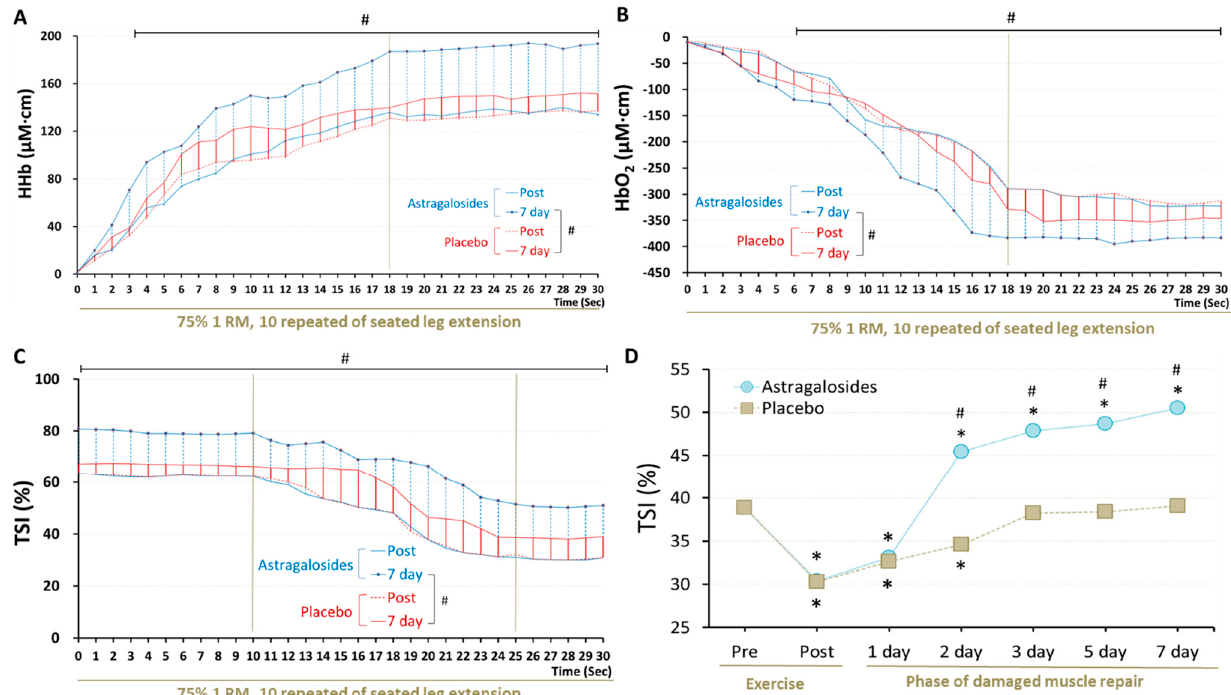
Figure 4. Effect of astragalosides supplementation on recovery of muscle oxygenation capacity after muscle damage. ( A ) The vastus lateralis muscle deoxyhemoglobin (HHb), ( B ) oxyhemoglobin (O 2 Hb), ( C ) tissue oxygen saturation index (TSI), and ( D ) TSI at last 5 s of seated leg extension were monitored under 10 repititions of 75% 1 RM seated leg extension. # indicates the main significant effect for the group ( p < 0.05). * p < 0.05 vs. pre-exercise for the same group.